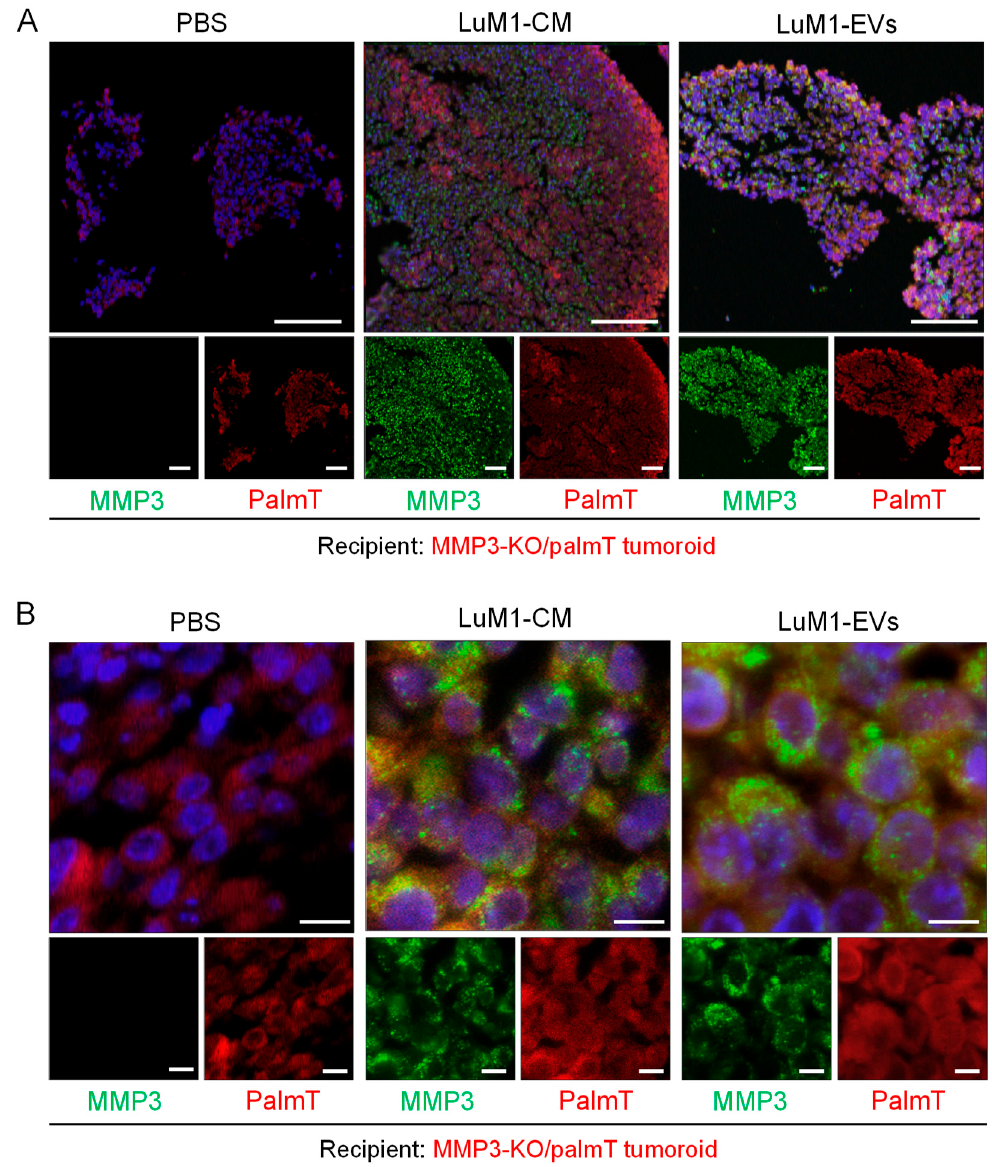
Figure 8. The EV-mediated deep transfer of MMP3 into tumoroids. MMP3-KO / palmT (red) tumoroids were treated with PBS, LuM1-CM, or LuM1-EVs for 24 h in the ULA-based 3D culture system. MMP3 (green) was stained by immunofluorescence. Nuclei were stained blue with DAPI. Images were taken by CLSM. ( A ) low and ( B ) high magnifications were shown. Top images, merge of three color. Scale bars; 100 μ m (in low magnification images) and 10 μ m (in high magnification images).